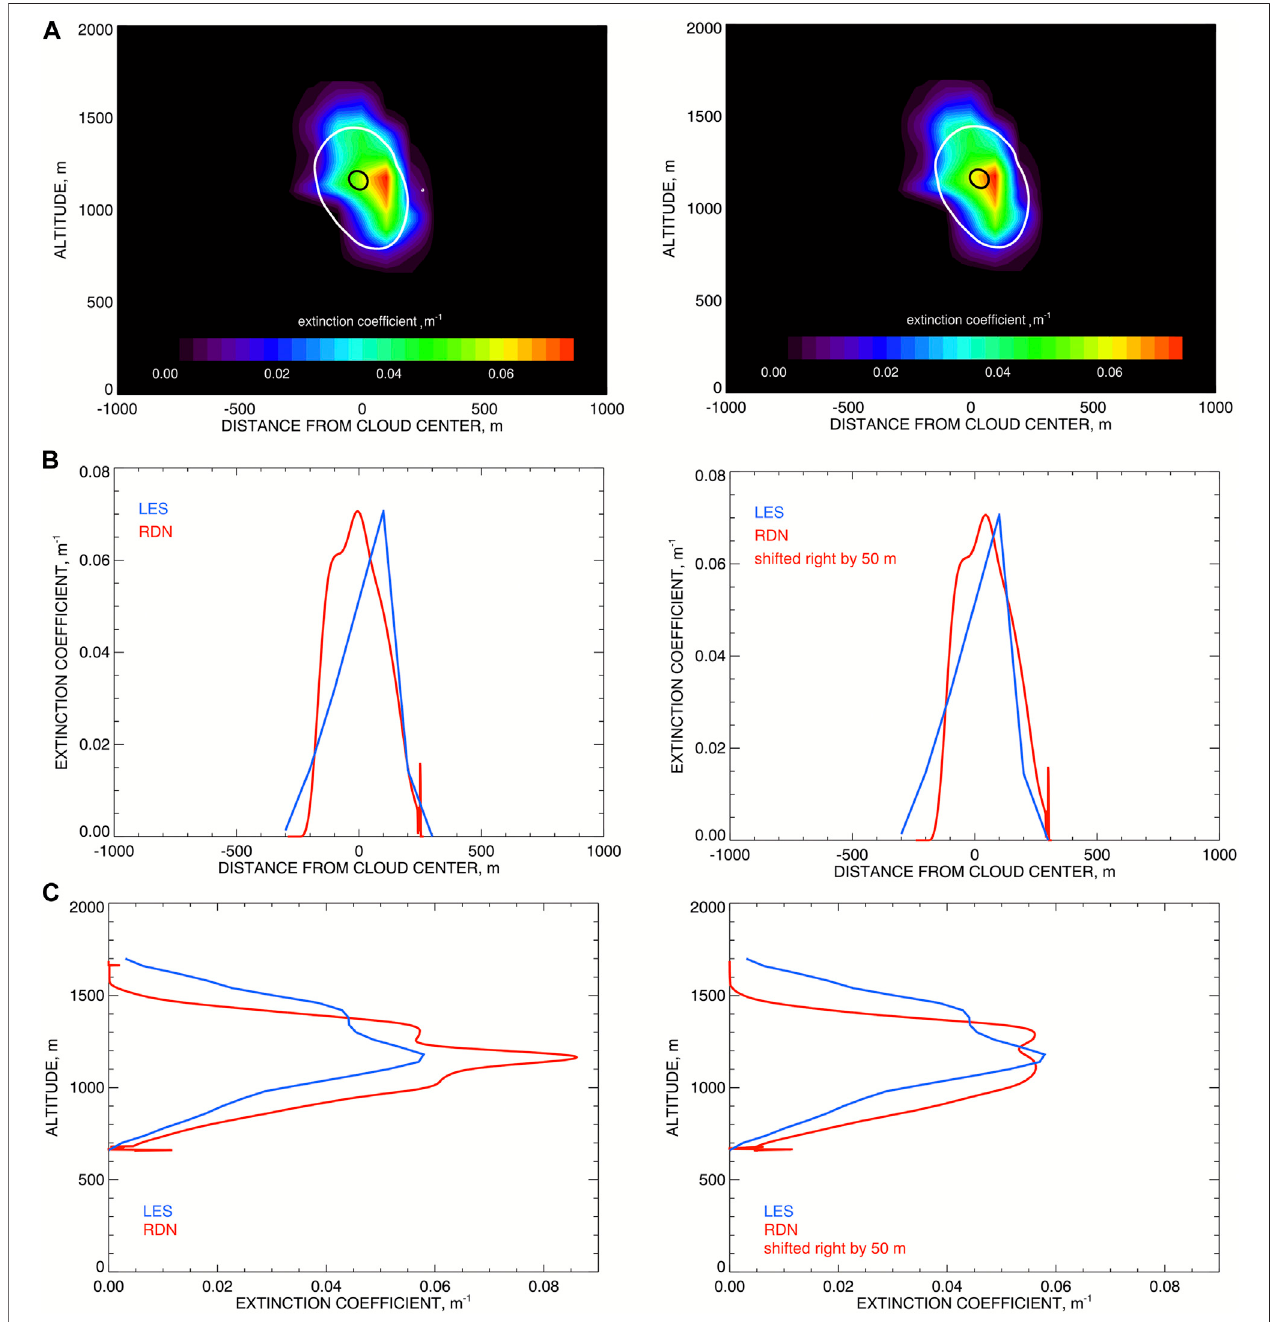
FIGURE 10 | Comparison between the tomographic retrievals of the extinction coef fi cient from Figure 8B with the initial LES fi eld. (A) Color contour plot of LES extinction coef fi cient with the level curves of the retrieved distribution being over-plotted: white curve corresponds to k ext (cid:1) 0.02 m − 1 , black — to k ext (cid:1) 0.07 m − 1 (these values are represented by blue and red respectively in the color plot). (B) Same as top but along horizontal cross section at 1,100 m altitude. (C) same as top but along vertical cross section the cloud center. Left column presents the original retrievals, while in right column the retrieval fi eld is shifted by 50 m to the right (away from the bright side of the